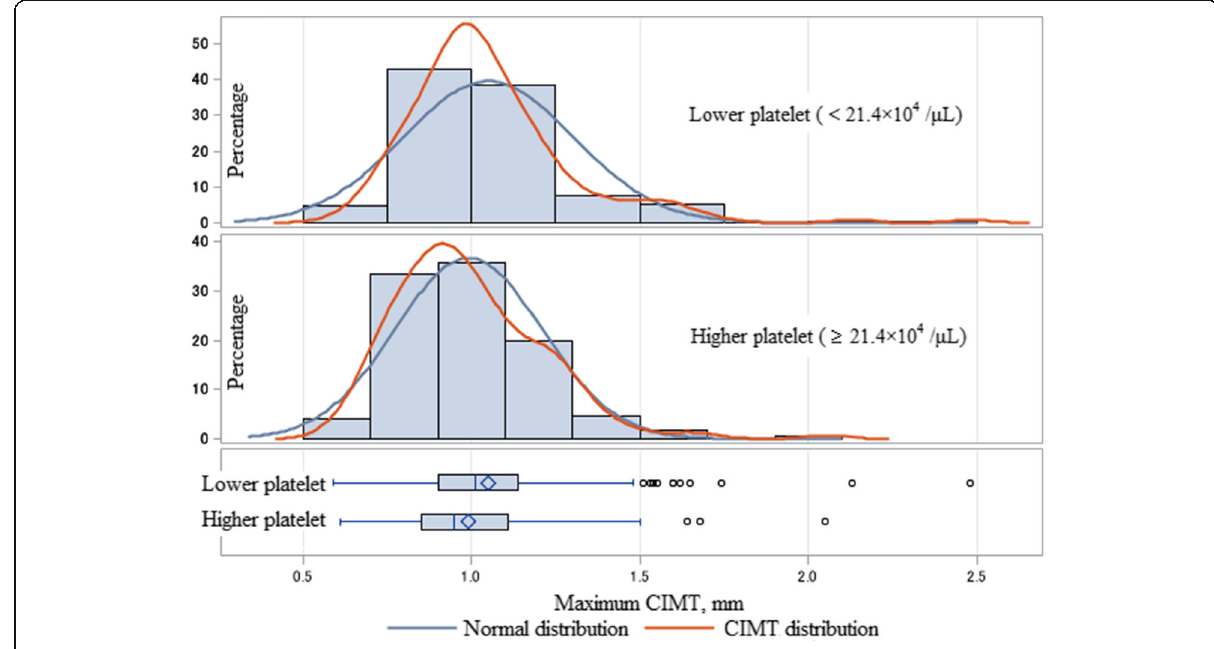
Fig. 1 Distribution of maximum carotid intima-media thickness (CIMT) by platelet